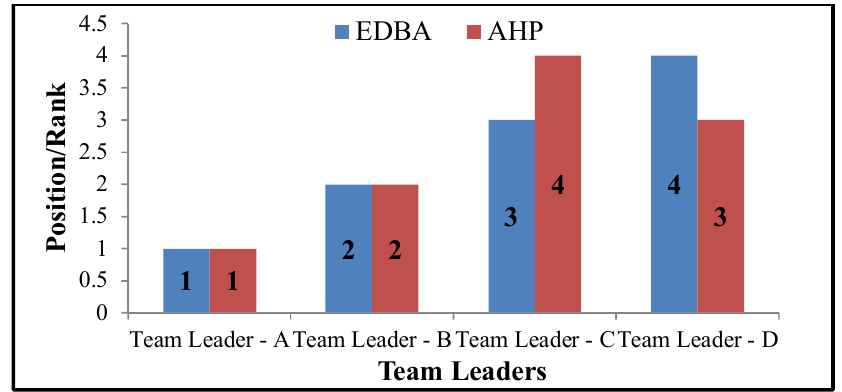
Fig 4. Rankings of Team Leaders obtained from EDBA